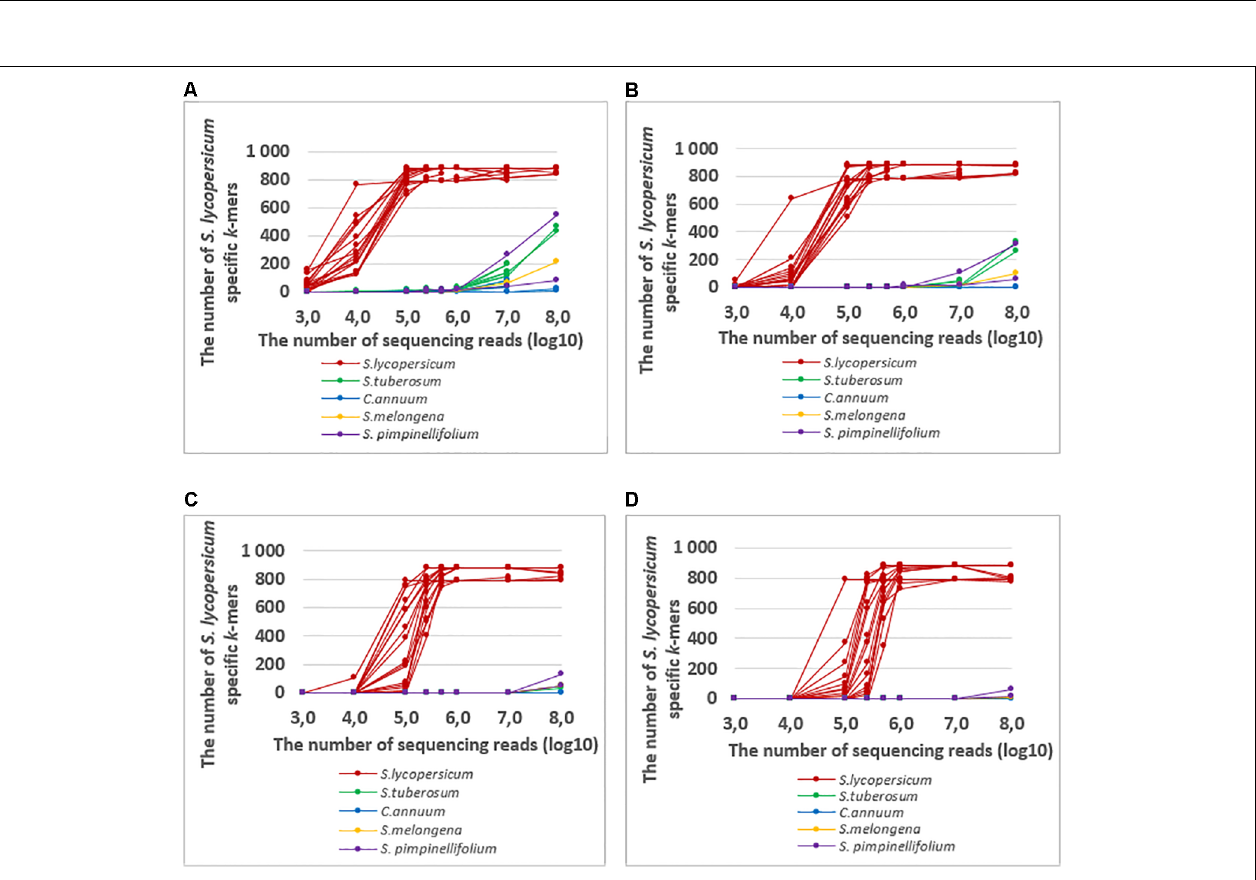
FIGURE 6 | The numbers of detected S. lycopersicum specific k-mers with frequencies of at least (A) 1, (B) 2, (C) 5, and (D) 10 in the whole genome sequencing raw data from S. lycopersicum, S. pimpinellifolium, S. tuberosum, S. melongena, and C. annuum with variable numbers of sequencing reads (10 3 –10 8 ). The detected S. lycopersicum specific k -mers were present in at least 2 S. lycopersicum chloroplast